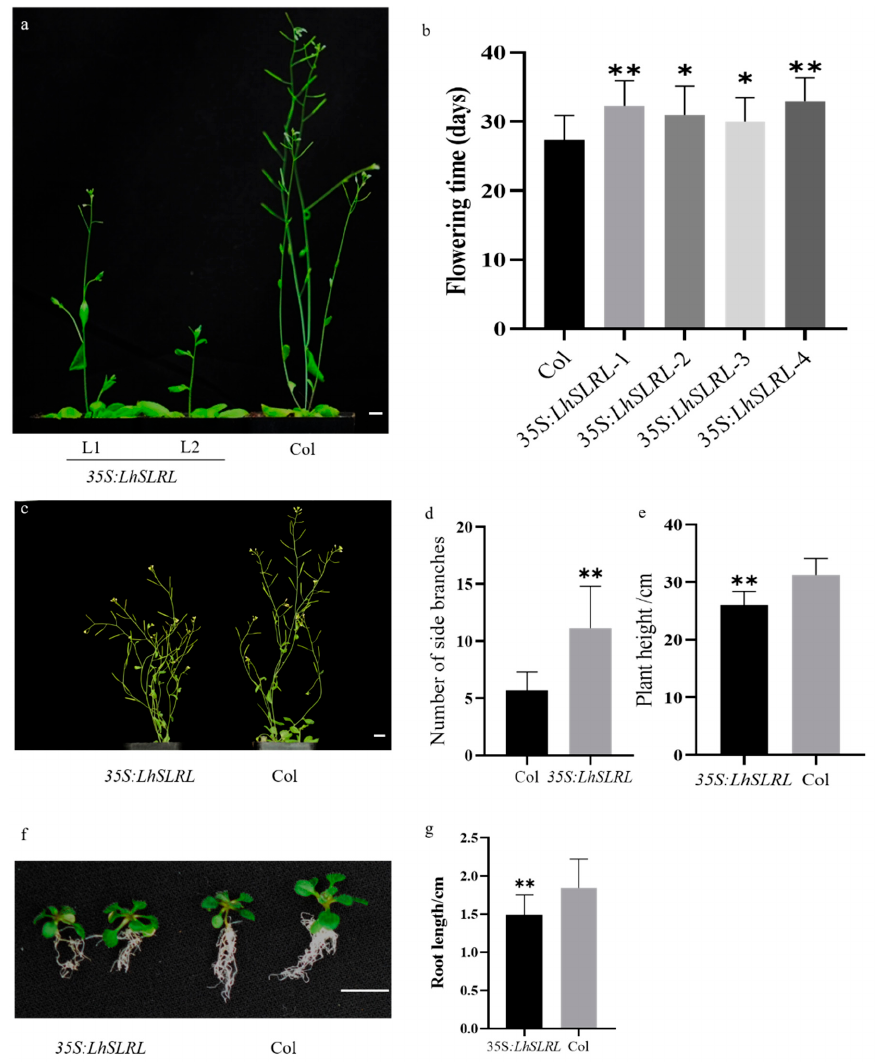
Figure 5. Morphological phenotypes of Arabidopsis overexpressing LhSLRL . ( a ) Phenotypes of 40-day-old wild-type and transgenic plants. ( b ) Measurement of flowering time in the wild-type and transgenic lines ( a ). ( c ) Phenotypes of 55-day-old wild-type and transgenic plants. ( d ) Number of side branches in the wild-type and transgenic lines ( c ). ( e ) Measurement of plant height branches in the wild-type and transgenic lines ( c ). ( f ) Phenotypes of 15-day-old wild-type and transgenic plants. ( g ) Measurement of root length in the wild-type and transgenic lines ( f ). Error bars: ± SD. * p < 0.05; ** p < 0.01. Scale bars: 1 cm ( a , c , f ).